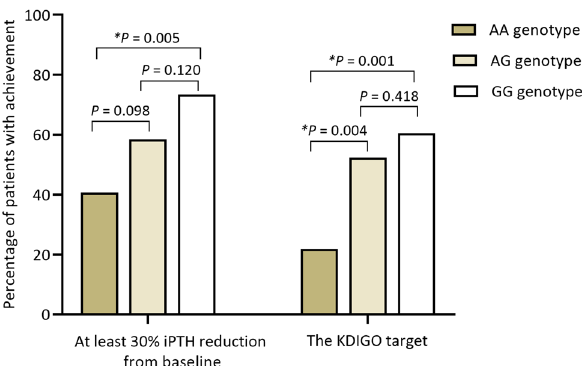
Figure 3. The percentage of patients that achieved at least 30% reduction of intact parathyroid hormone concentration from baseline and the KDIGO recommended PTH target of two to nine times upper limit for the assay used for dialysis patients (130–585 pg/mL) after 12 weeks of cinacalcet treatment. The data were compared by chi-square test. *p < 0.05 was considered statistically